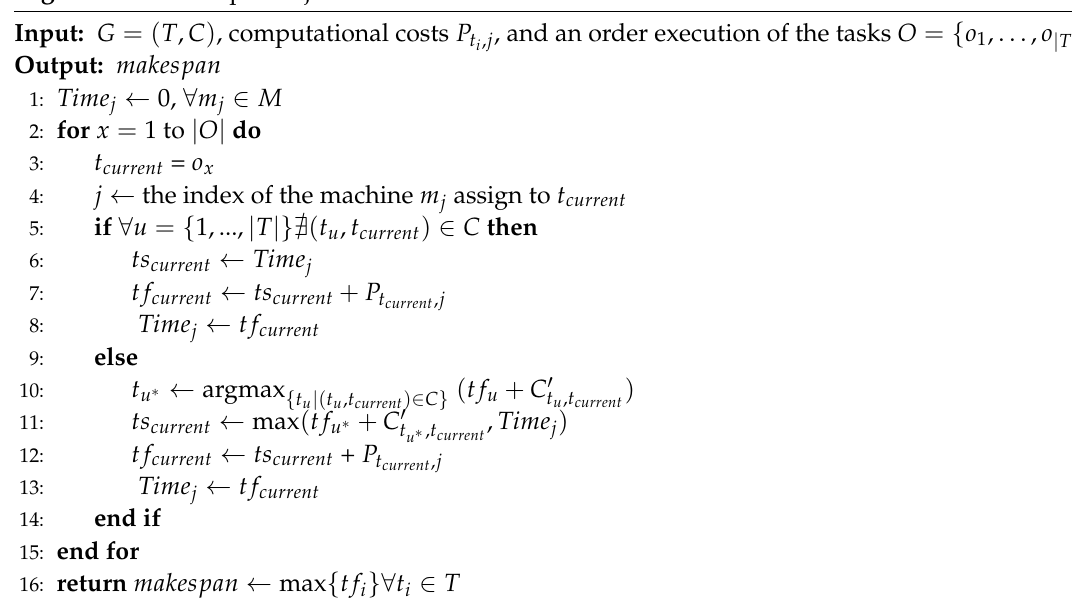
Algorithm 1 Makespan objective